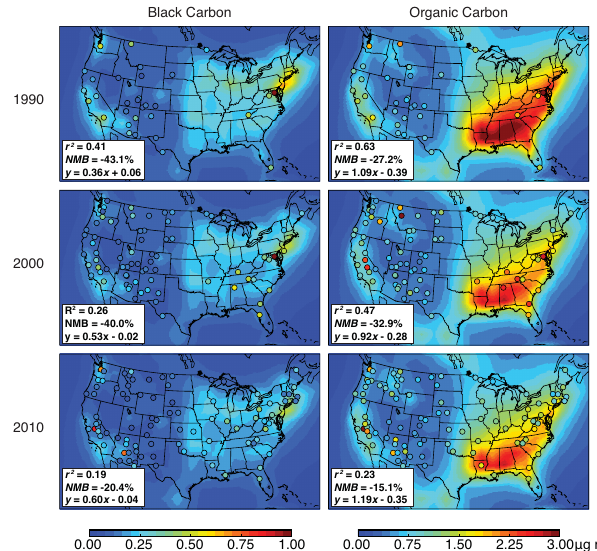
Fig. 6. Black carbon (left) and organic carbon (right) concentration in surface air (µgm − 3 ) . Observations (circles) are 3-yr averages for 1989–1991, 1999–2001, and 2008–2009. GEOS-Chem model values (background contours) are from the decadal time slice simu- lations with 1990, 2000, and 2010 emissions. Reduced major axis linear regressions between model and observations are shown inset for each map along with the coefficient of determination ( r 2 ) and normalized mean bias